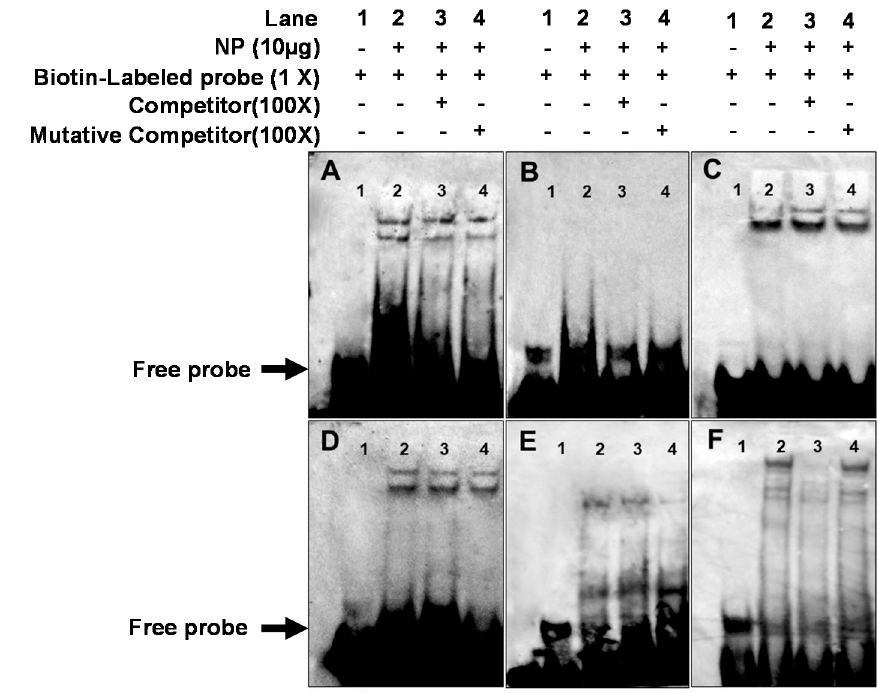
Figure 7. Electrophoretic mobility-shift assay (EMSA) of putative PPAR binding sequences. The 5 ′ -biotin labeled double-stranded oligomers were incubated with HepG2 nuclear extract ( NP ). A 100-fold excess of the competitor and Mutative competitor oligomers was added to the competition and mutant competition assay, respectively. The oligonucleotide sequences are given in Table 1. ( A ) PPAR α /RXR binding sequence located at − 1814 bp to − 1836 bp of CPT I α 1b promoter ( B ) PPAR γ binding sequence located at − 1719 bp to − 1741 bp of CPT I α 1b promoter ( C ) PPAR α /RXR binding sequence located at − 1939 bp to − 1961 bp of CPT I α 2a promoter ( D ) PPAR γ binding sequence located at − 1179 bp to − 1201 bp of CPT I α 2a promoter ( E ) PPAR γ binding sequence located at − 1104 bp to − 1136 bp of CPT I α 2a promoter ( F ) PPAR γ binding sequence located at − 1044 bp to − 1066 bp of CPT I α 2a promoter.